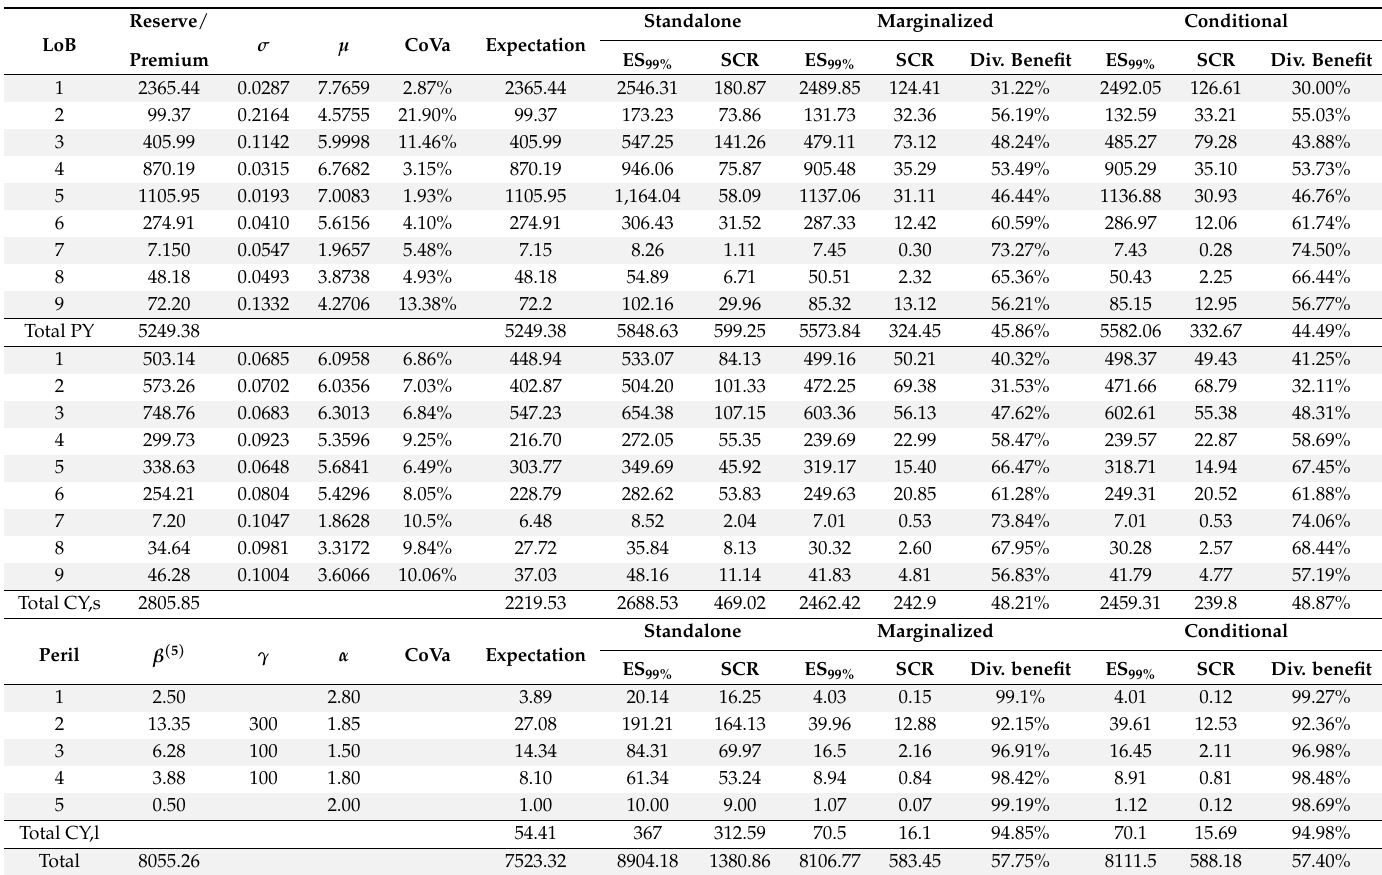
Table 2. Parameters and capital calculations for the marginalized and conditional